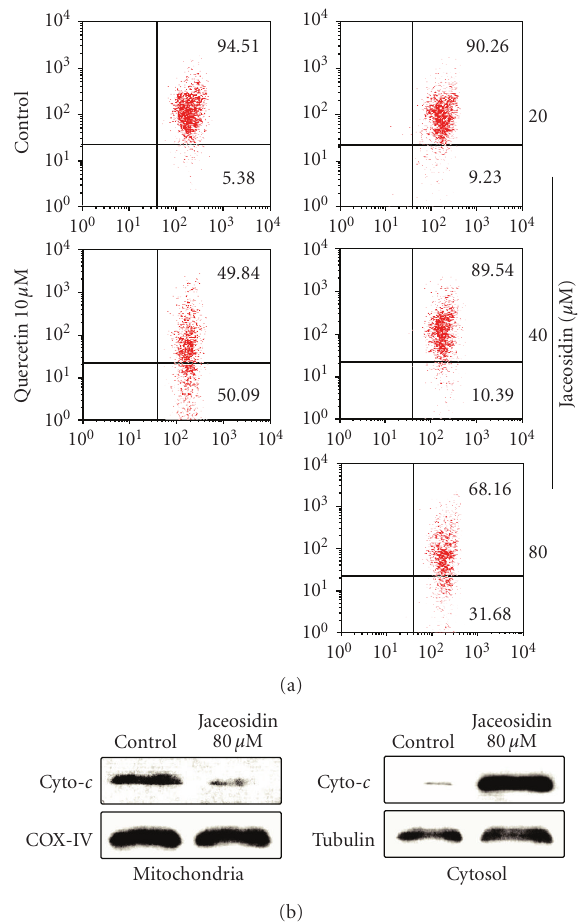
Figure 3: Jaceosidin dose-dependently (a) induces loss of mito- chondrial membrane potential and (b) induces cytochrome c to release from mitochondria to cytosol. CAOV-3 cells were seeded into 12-well-plate and cultured overnight. Jaceosidin or quercetin was added into each well. Twenty-four hours later, cells were harvested for measuring mitochondrial membrane potential by flow cytometry using JC-1 staining. Cells on the lower side showed lower membrane potential. One of three independent experiments is shown. In addition, mitochondria and cytosol proteins were prepared from cells treated with 80 μ M jaceosidin, which were subjected to western blotting for measuring cytochrome c in mitochondria and cytosol.